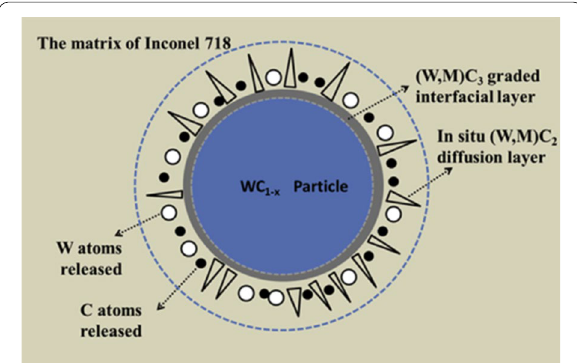
Figure 13 Schematic diagram of the generation mechanism of the interfacial graded layer